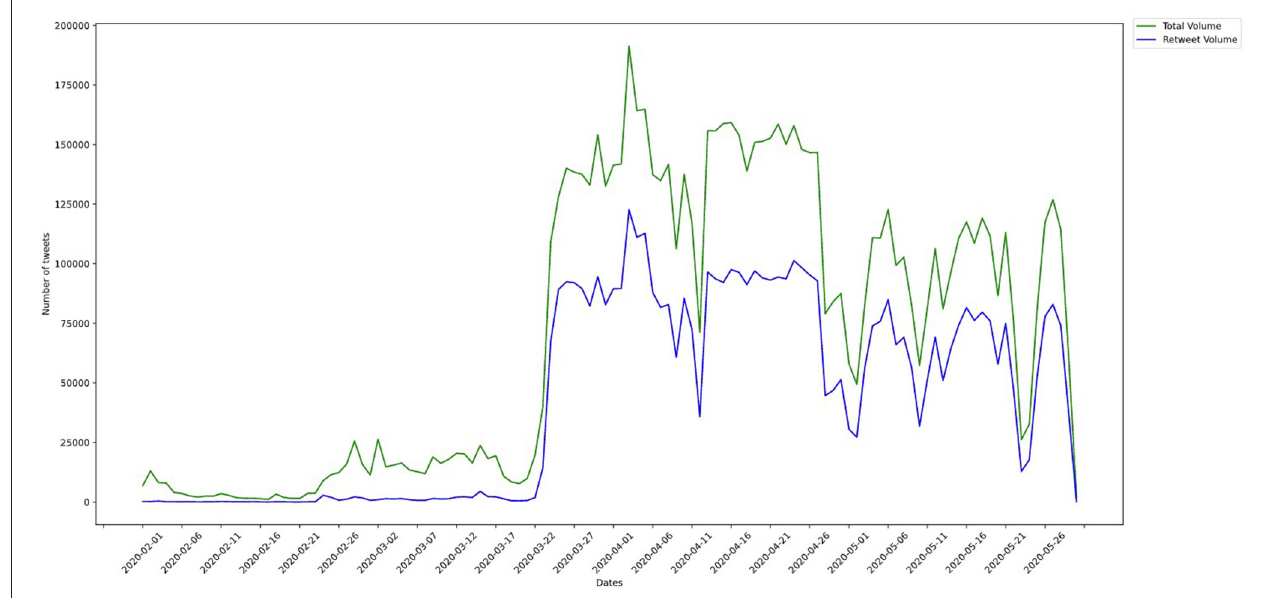
FIGURE 1 | Time series of volume of tweets and retweets in combined dataset.